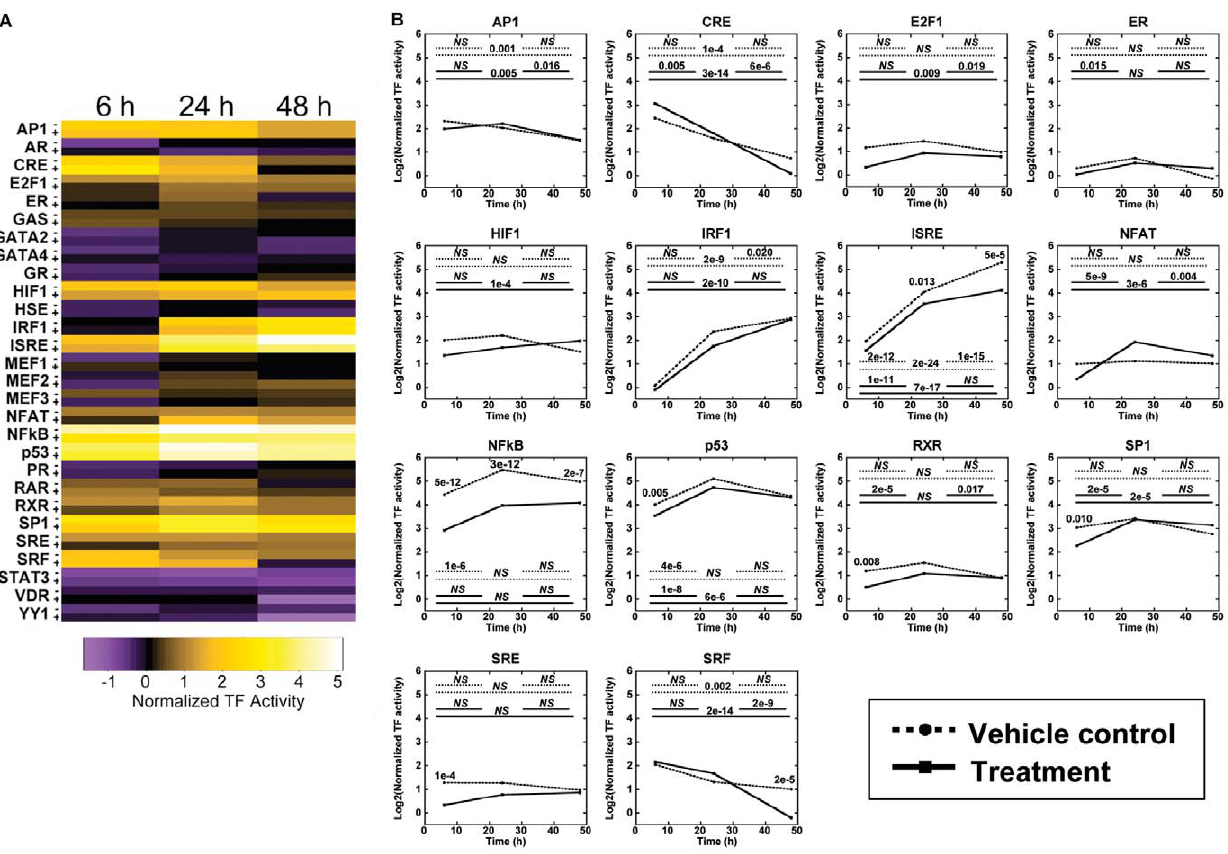
Figure 6. Dynamic large-scale activities of TFs in response to activin A treatment. (A) TFs had variable activities as functions of treatment and time, as indicated by a heat map representation of log 2 transformation of the means. Vehicle control indicated by ‘ 2 ’ and activin A treatment indicated by ‘ + ’. (B) TFs that had significant changes with treatment or time are presented on individual temporal plots, with log 2 transformations of the TF activity means plotted. Dashed lines represent vehicle control and solid lines represent activin A treatment. Statistical comparisons are described in legend of Figure 5. Values are log 2 transformed means from at least three independent experiments carried out in duplicate for each condition.